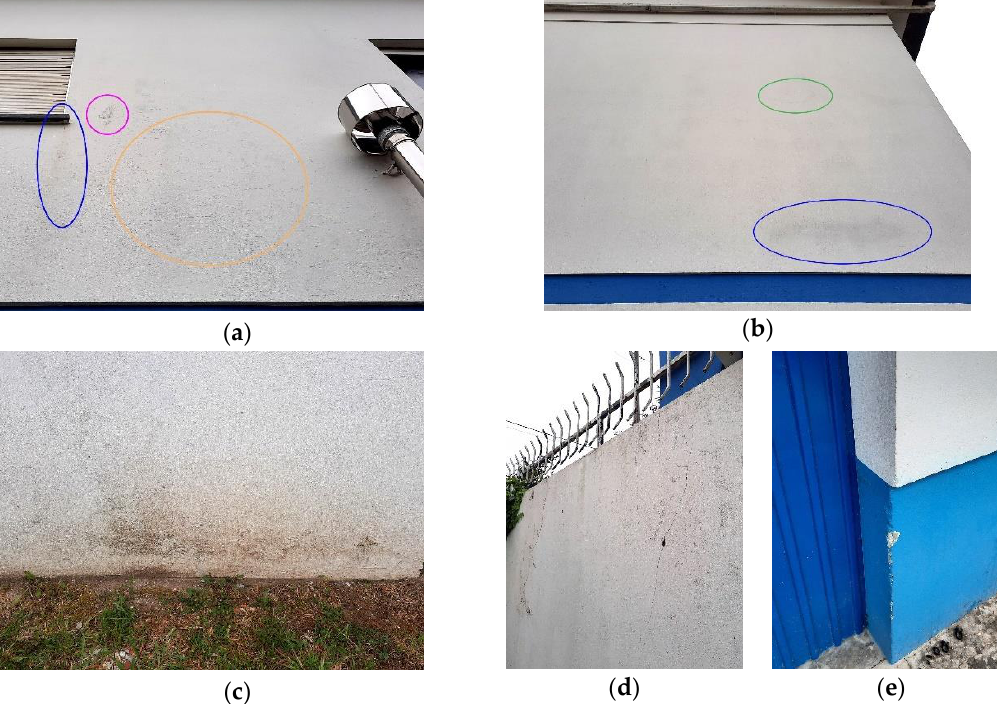
Figure 7. Defects detected on the façades of the case study: ( a ) moisture stains (highlighted in blue), biological colonisation (pink) and mapped cracking (orange); ( b ) moisture stains (blue) and loss of adhesion (green); ( c ) sirt deposits and loss of adhesion of the finishing coat; ( d ) linear cracking and biological colonisation; and ( e ) scratches/grooves. All these causes correspond to reasonably inferred causes of the detected defects.